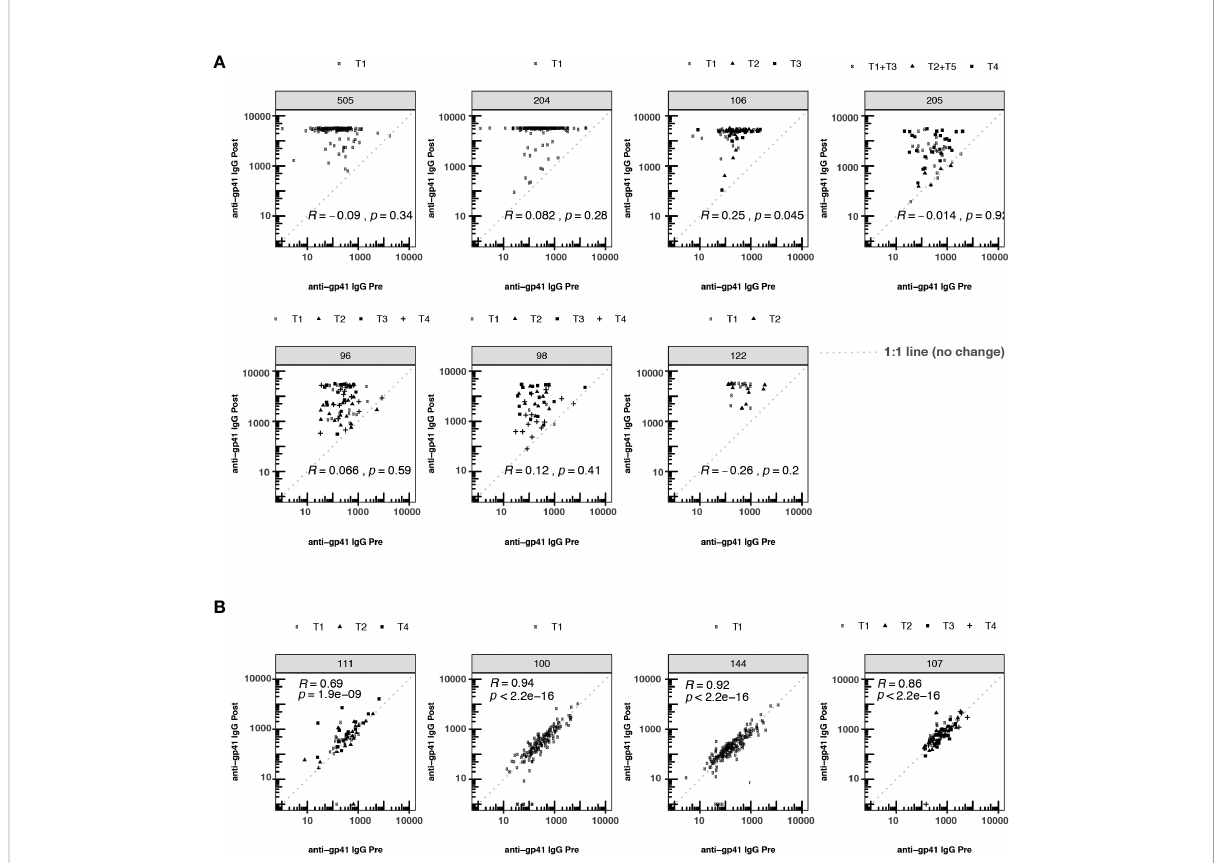
FIGURE 2 Participant-matched anti-gp41 IgG (MFI) pre- vs. post-vaccine for participants receiving either (A) vaccines containing gp41 immunogens or (B) vaccines lacking gp41 immunogens. Consistency in response magnitude in panel (B) , among participants receiving vaccines without gp41, shows the temporal stability of participants ’ anti-gp41 cross-reactive response between measurements collected 26-52 weeks apart. The dashed 1:1 line represents no change between pre- and post-timepoints. T1-T5 indicates speci fi c variation in vaccine dose regimen within a particular trial. Within each trial the nature of the gp41 immunogen was consistent across